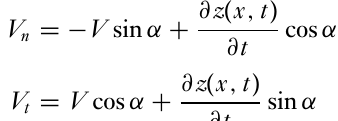
where ρ is density of the fluid; surface relative to liquid; relative to liquid; C n , drag coefficient in normal direction; and C t , drag coefficient in tangent direction.